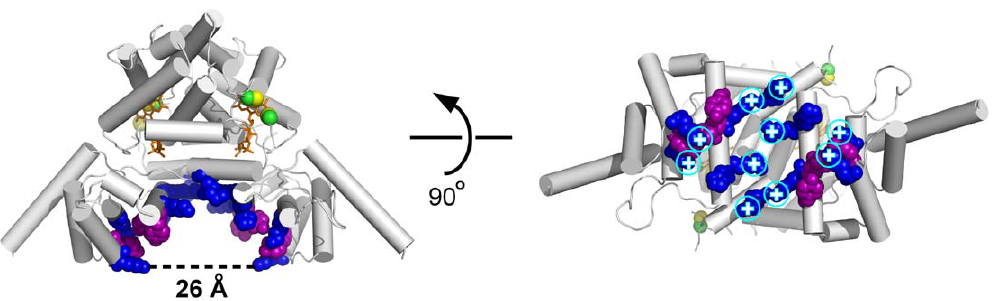
Figure 3. Character of the concave face of R596-4C. Exposed basic and aromatic residues in the groove between the ORFan domains are shown in space-filling representation. Phenylalanine and tyrosine residues are purple; arginine, lysine, and histidine are blue. In the view into the groove (right), arginine and lysine side chains are marked with a circled + symbol.